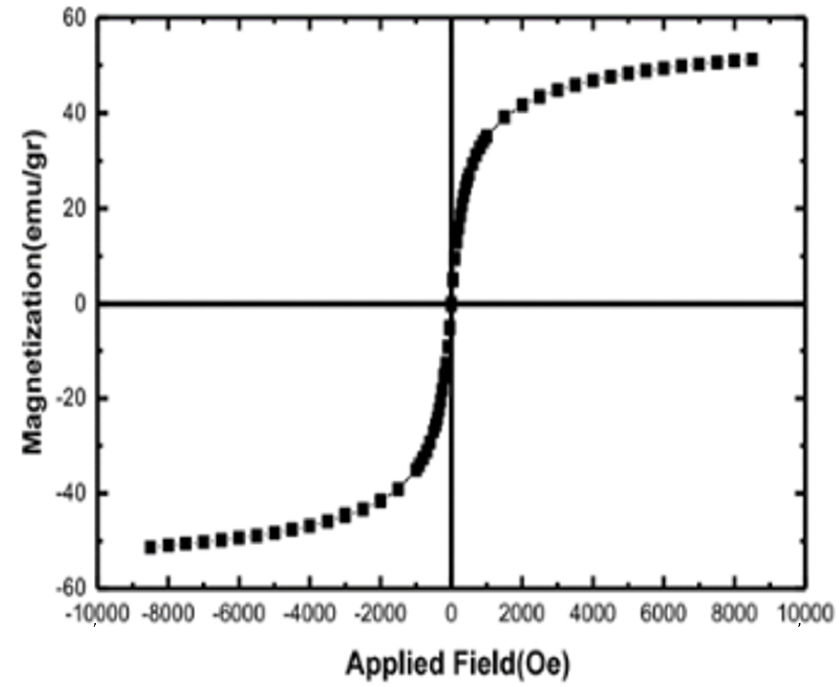
Figure 4. VSM analysis of the Ni-based mMOF nanomaterials.